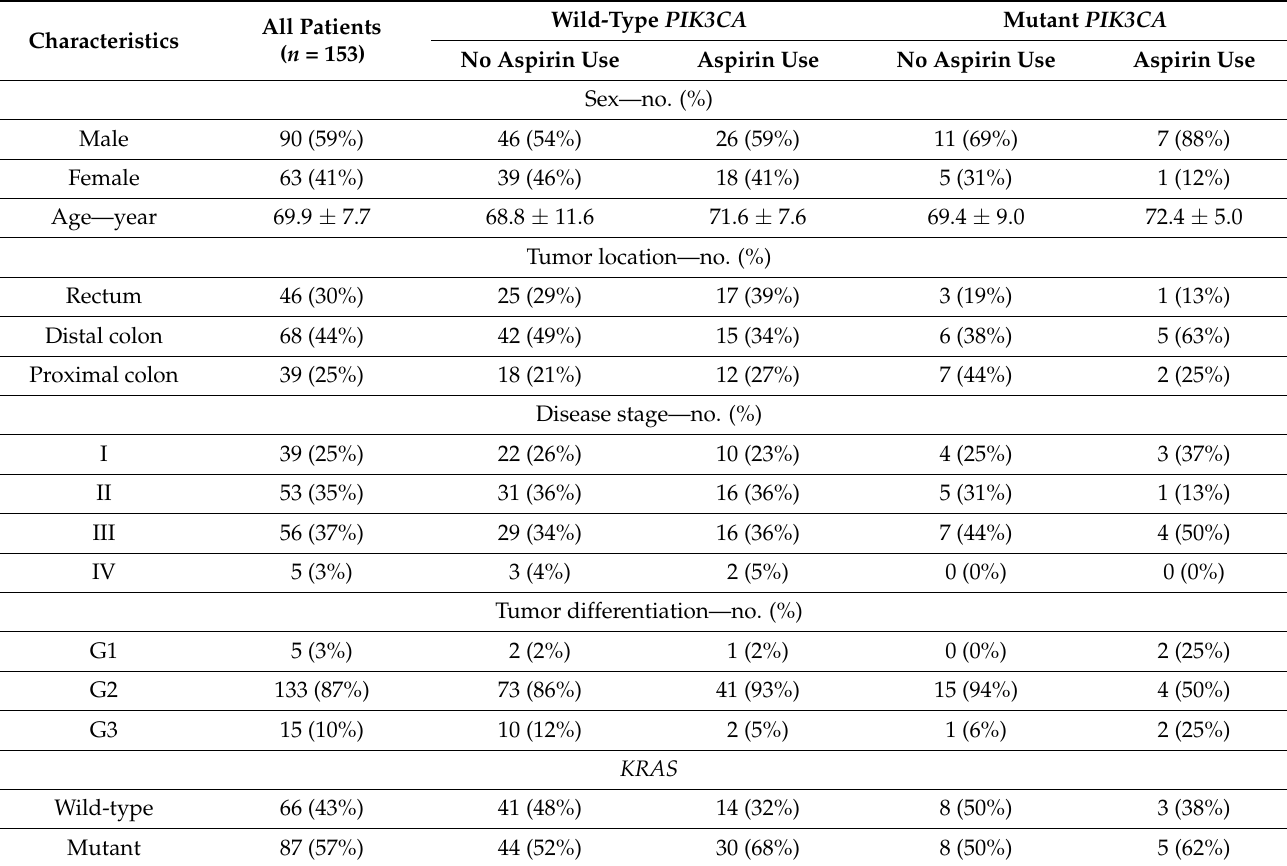
Table 1. Baseline characteristics of patients with colorectal cancer, according to PIK3CA (phosphatidylinositol-4,5- bisphosphate 3-kinase, catalytic subunit alpha) mutational status and regular use or nonuse of aspirin after diagnosis. Characteristics